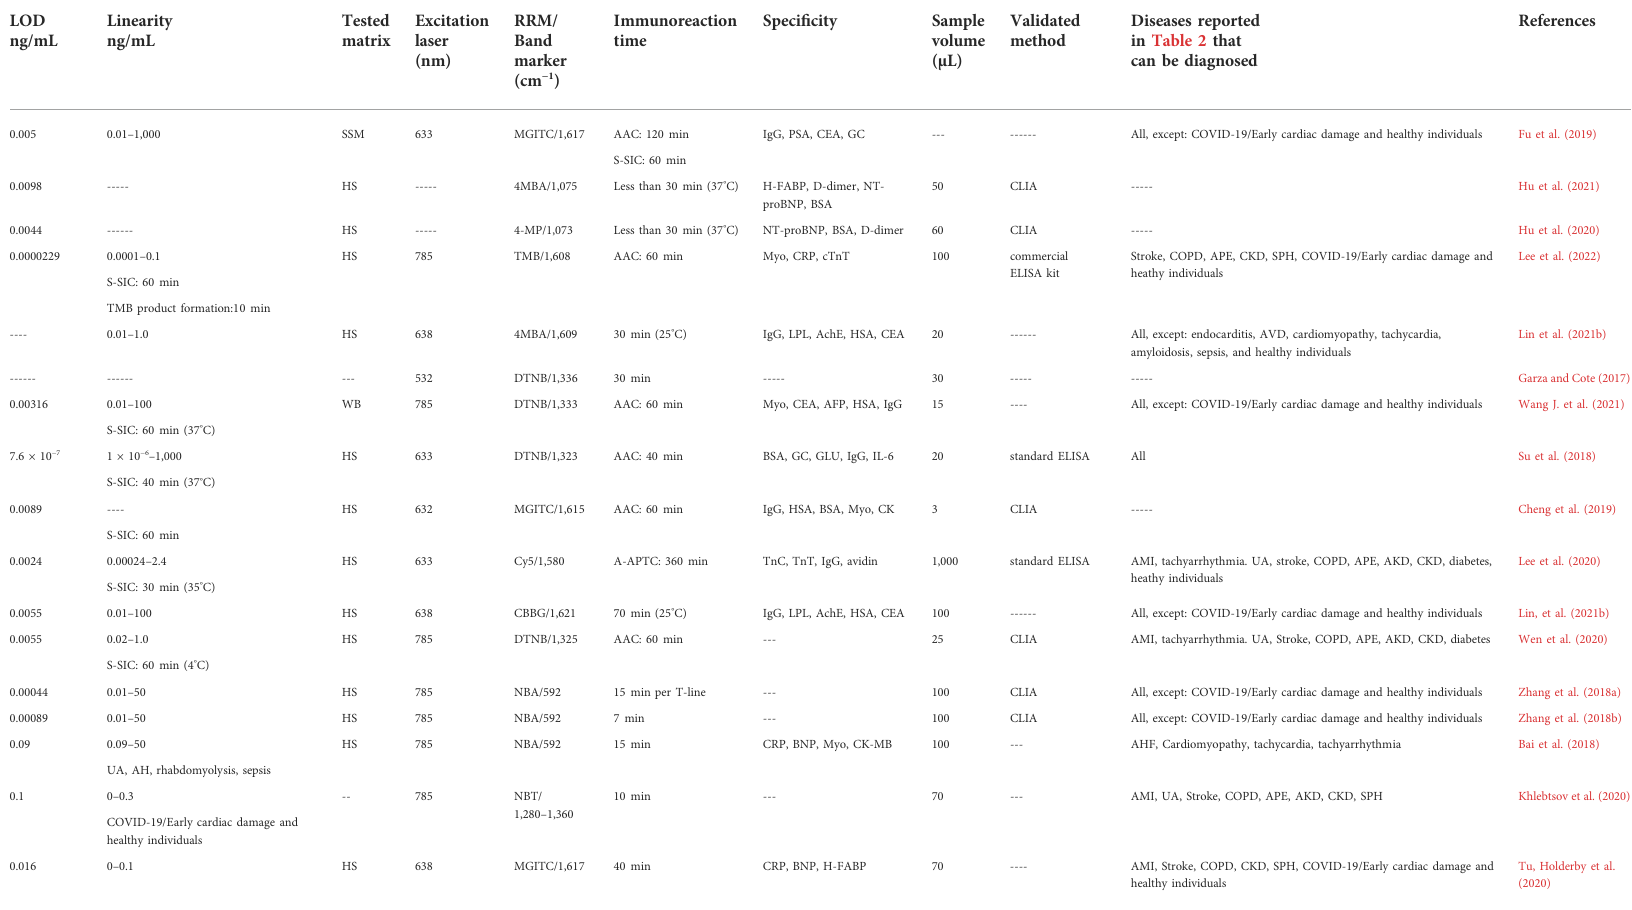
TABLE 3 Immunoassays for cTnI measurement taken from the literature published between the years 2016 –